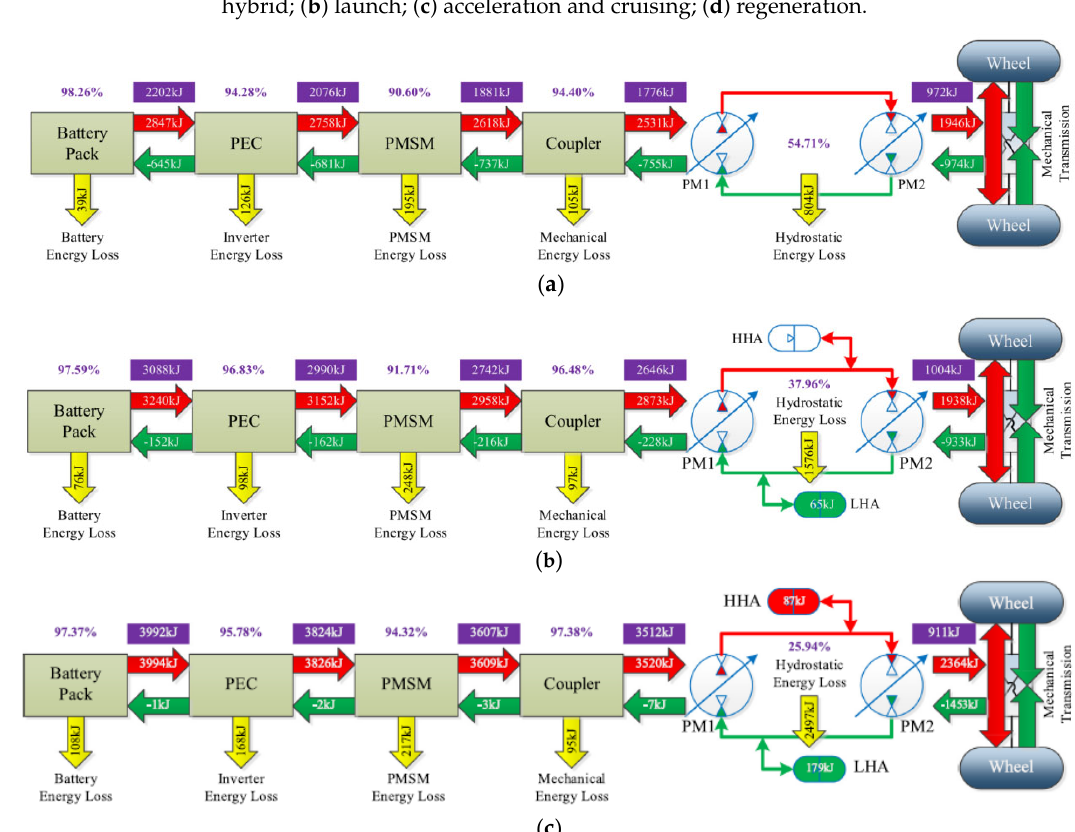
Figure 6. Configuration and energy flow of hydraulic electric hybrid vehicles [48,49,53,71]: ( a ) series hybrid; ( b ) launch; ( c ) acceleration and cruising; ( d ) regeneration.